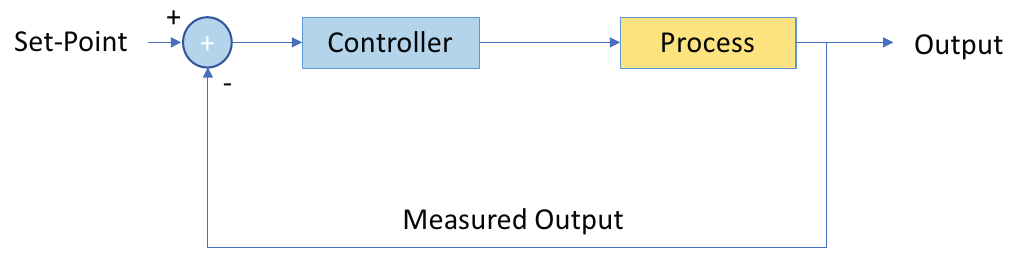
Figure 1. Diagram of a control